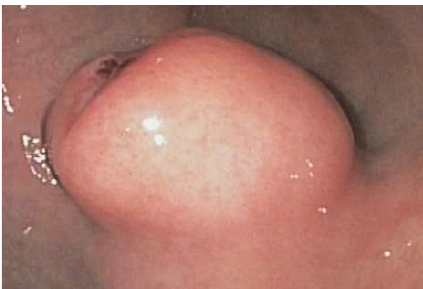
Figure 1: Ulcerated gastric glomus tumor, gross appearance.